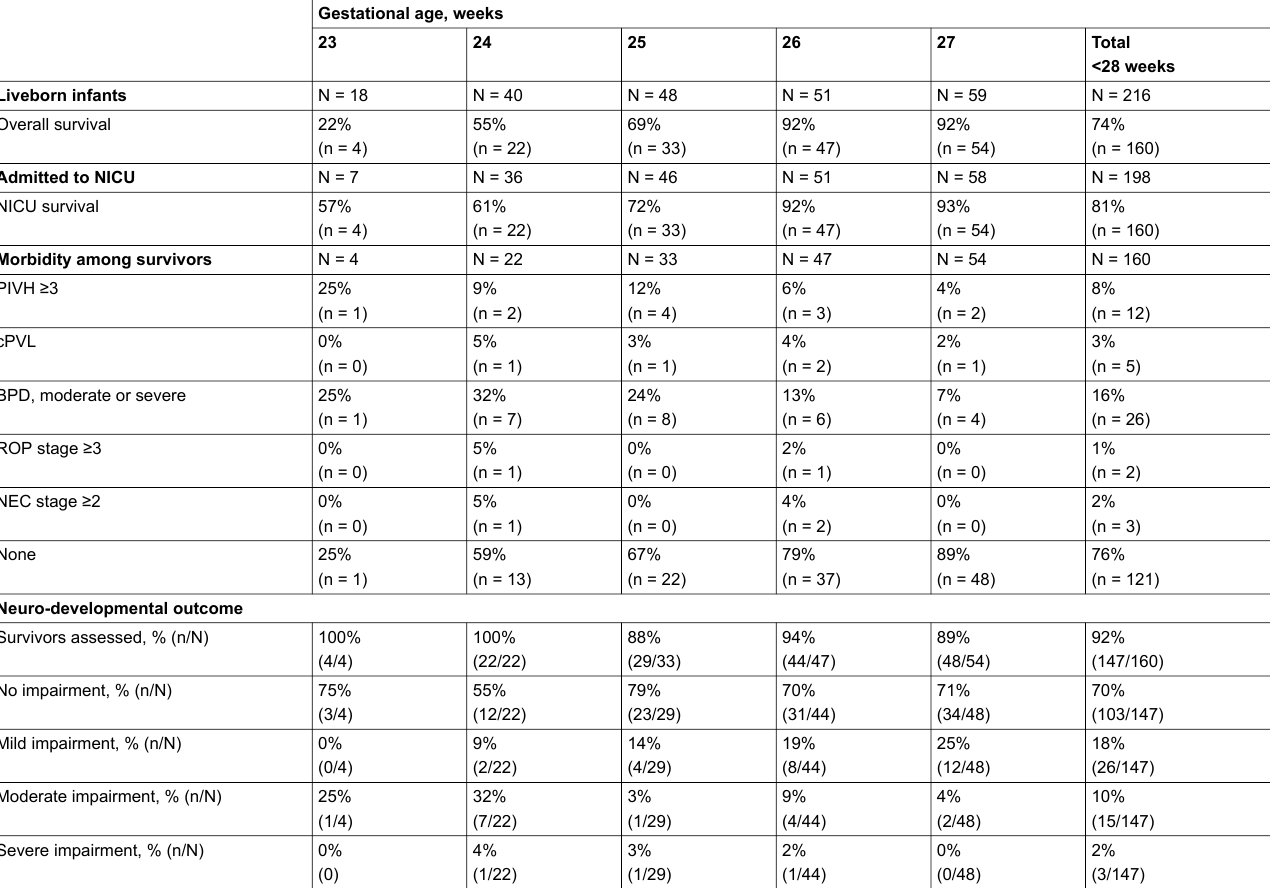
Table 2: Gestational age-specific survival, morbidity rates and rates of neuro-developmental impairment among ELGAN patient population cared for at the Children‘s Hospital of Lucerne between 2000 and 2009. PIVH = periventricular/intraventricular haemorrhage; cPVL = cystic periventricular leukomalacia; BPD = bronchopulmonary dysplasia; ROP= retinopathy of prematurity; NEC = necrotising enterocolitis). Gestational age,